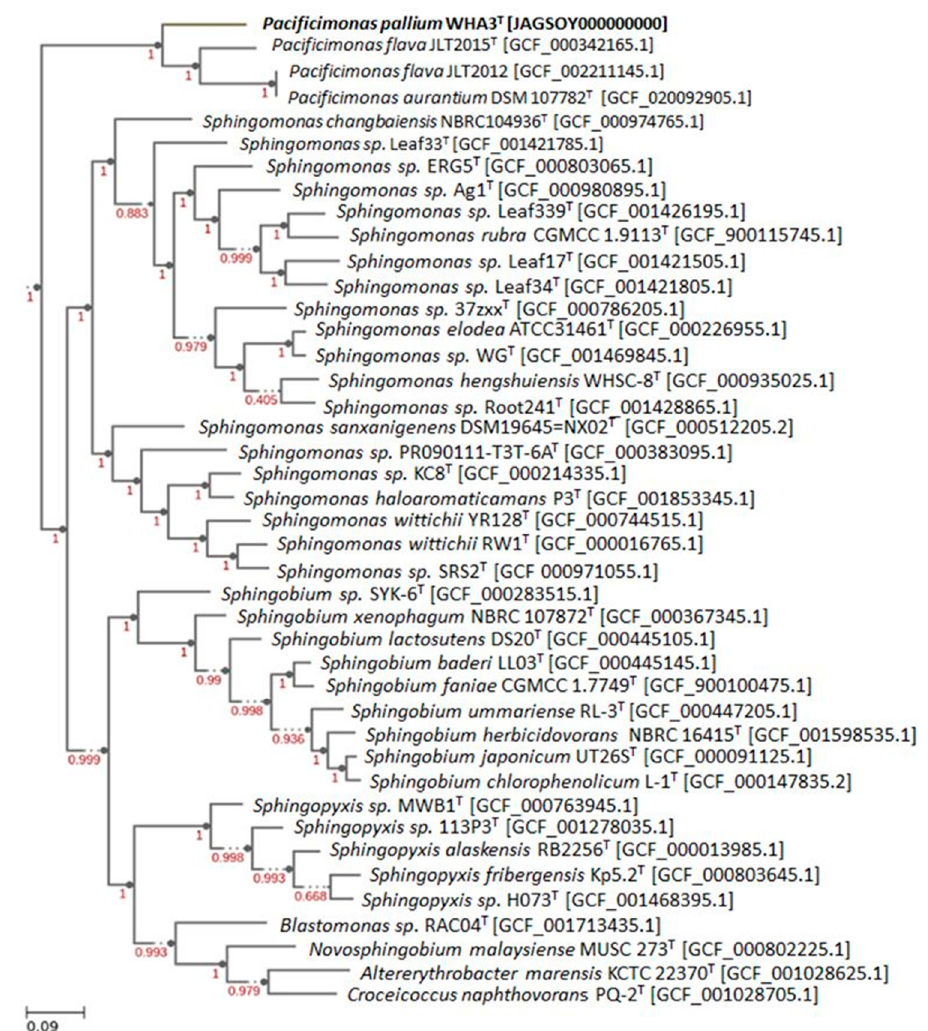
Figure 4. Phylogenomic tree showing relationships between strain WHA3 T and the closely related type strains based on the Insert Genome Into Species Tree v2.2.0 tool using 49 COG (clusters of orthologous groups) domains of core universal genes. Table 5. Genome relatedness between the strain WHA3 T , the genus of Pacificimonas , and other closet type strains according to the average amino acid identity (AAI) value and the